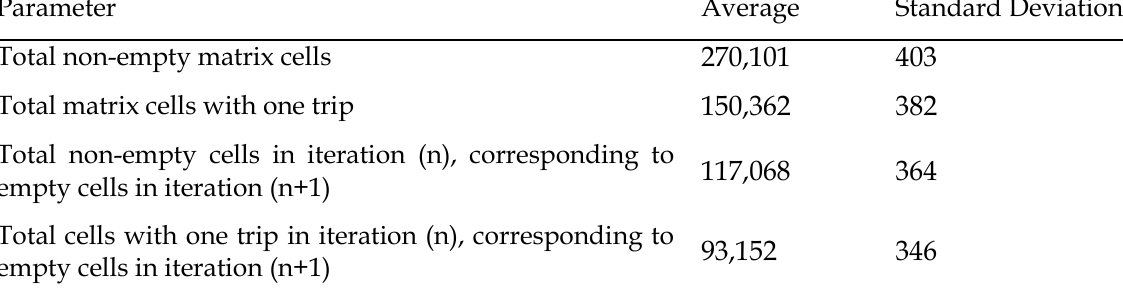
Total non-empty cells in iteration (n), corresponding to empty cells in iteration (n+1) Total cells with one trip in iteration (n), corresponding to empty cells in iteration (n+1) To conclude the analysis of demand matrix randomness, the overall coefficient of variation (CV) of the matrix was calculated (excluding cells, which are empty in both matrices): the average number of trips per cell is about 1.01, and standard deviation of cell changes is about 2.1, giving a relatively high CV value of about